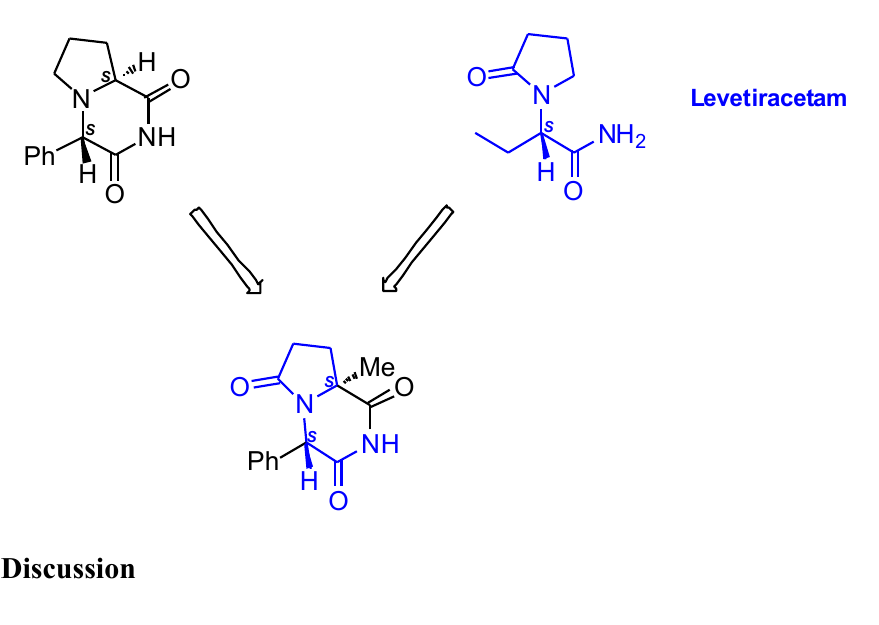
Figure 2. Hybrid compound of Levetiracetam and